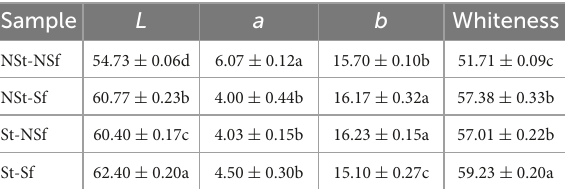
TABLE 1 Effect of steaming and sulfur fumigation treatment on the whiteness of Gastrodia elata starch. Sample L a b